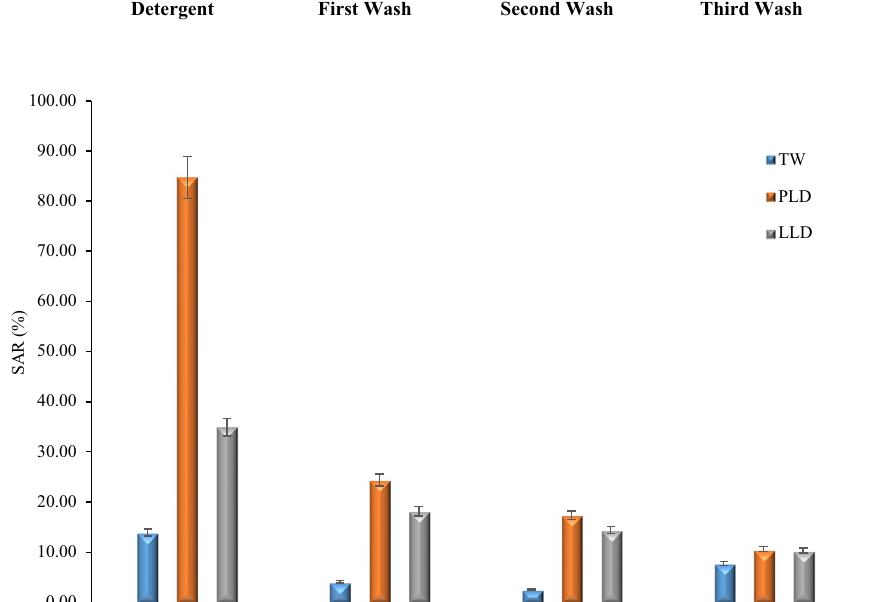
Fig. 5 Sodium adsorption ratio (SAR) of soil leachate after irrigated with tap water (TW), powder laundry detergent (PLD) and liquid laundry deter- gent (LLD)